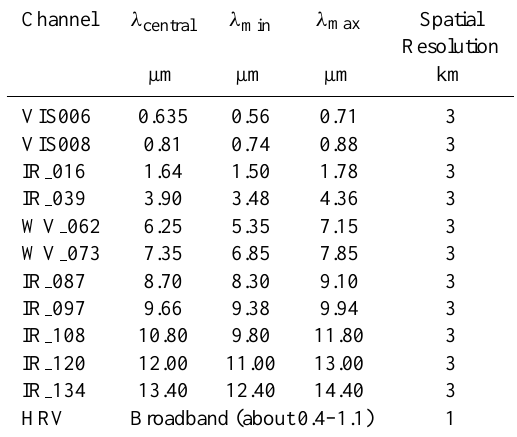
Table 1. SEVIRI spectral channels characteristics (Schmetz et al.,